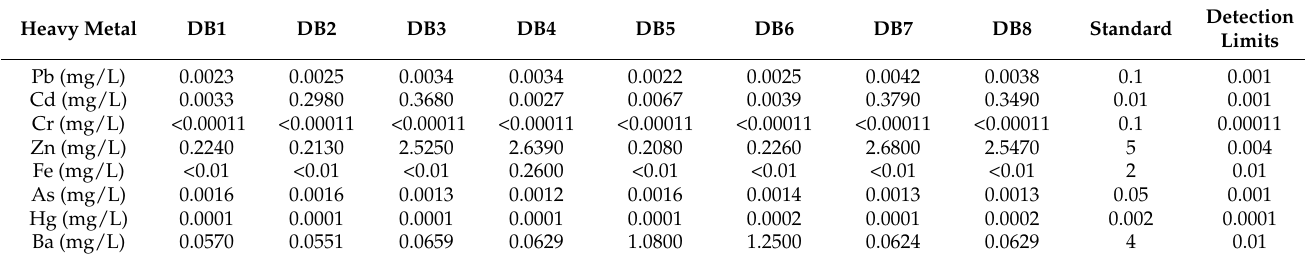
Table 1. Test results of the groundwater samples in the study area.